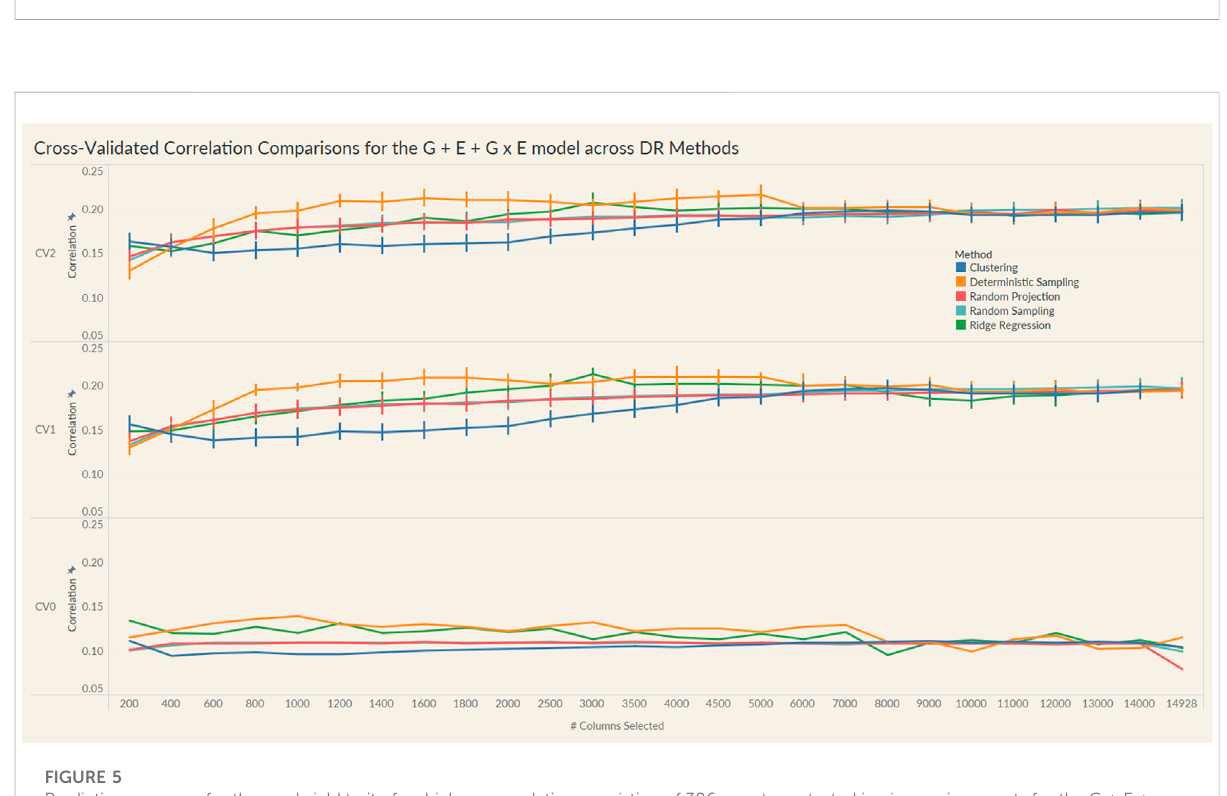
FIGURE 4 Prediction accuracy for the seed yield trait of a chickpea population consisting of 306 genotypes tested in nine environments for the G + E modelunderthethreecross-validationschemes(CV0,CV1,CV2)across26differentgenomicinformationsizes.Standarderrorsaredepictedateach size.